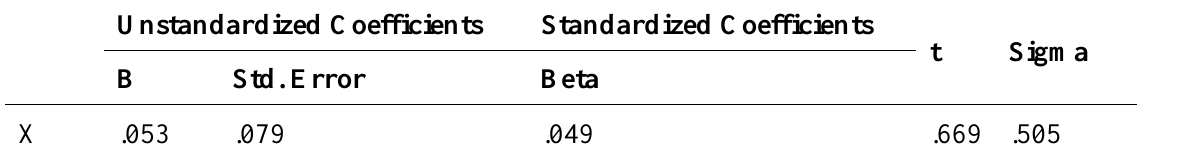
Table 8. T-test for model